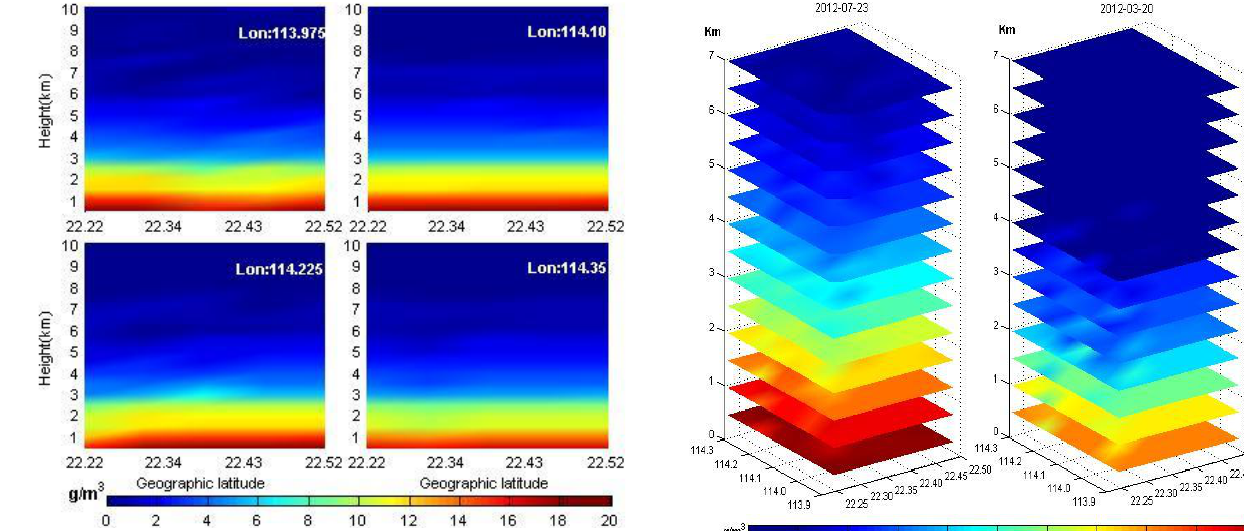
Fig. 7. Vertical profiles of tomographic water vapor at four different longitudes on July 23, 2012.